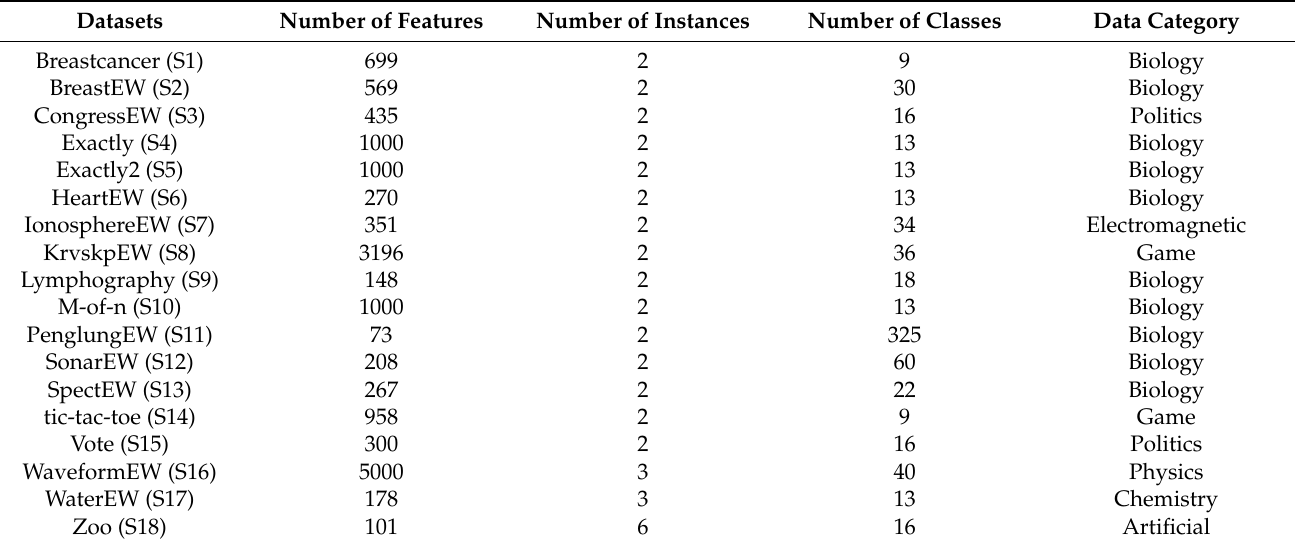
Table 1. Datasets’